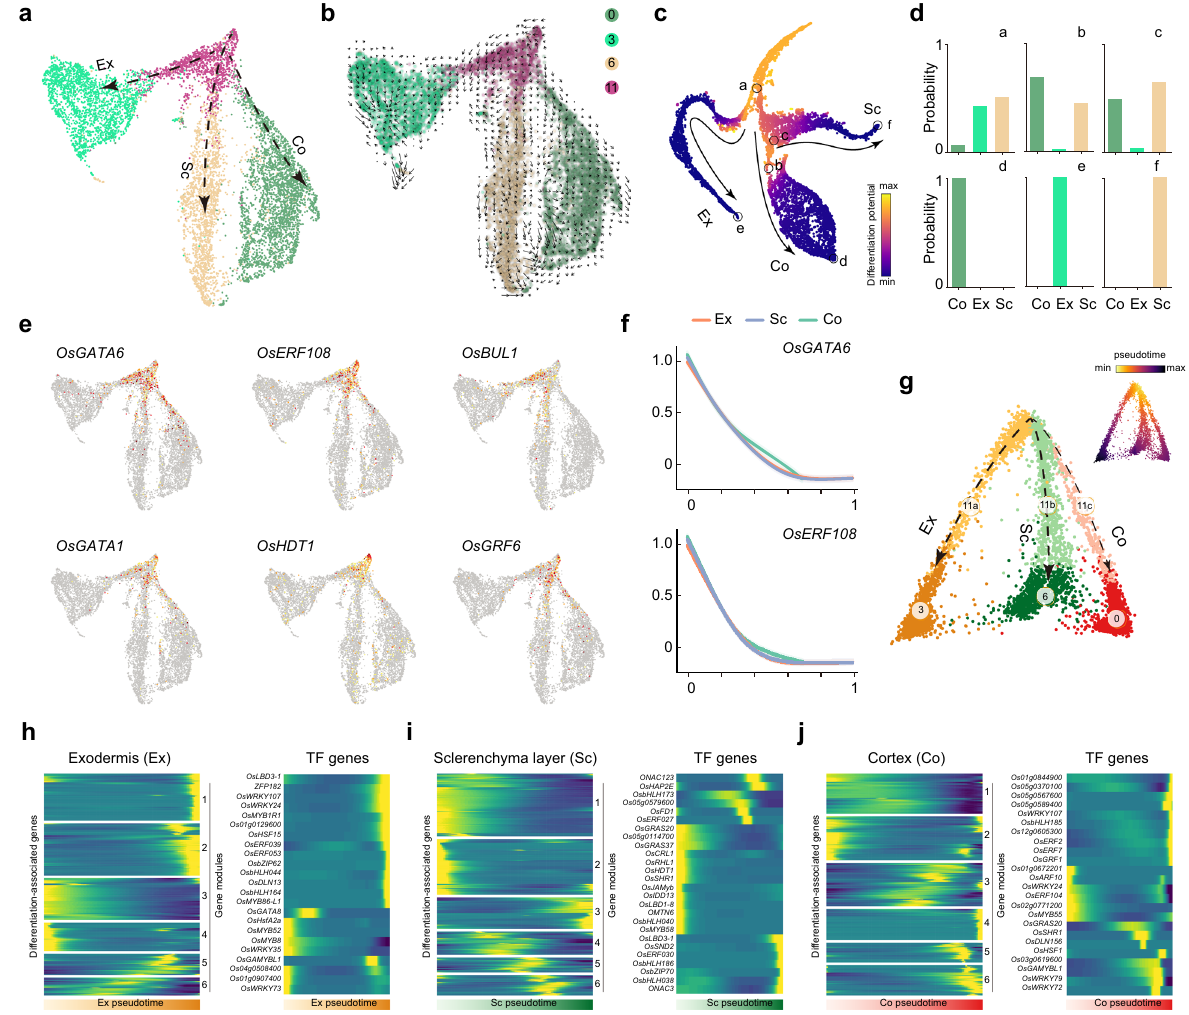
Fig. 3 Differentiation trajectories of ground tissue. a UMAP plot showing ground tissue cell populations. Ex, exodermis; Co, cortex; Sc, sclerenchyma layer. Cluster names (Clusters 0, 3, 6, and 11) and colors are the same as in Fig. 1a. b RNA velocity fi eld projected onto the UMAP. Arrows represent average velocity and direction. Cluster names and colors are the same as in a . c , d t -SNE map of ground tissue cell populations. Cell colored by differentiation potential ( c ). Black lines mark three major differentiation trajectories toward Ex, Co, and Sc, respectively. a to f (black circles), six nodes used for quanti fi cation of branch probabilities ( d ). e , f Expression patterns of selected transcription factor genes on UMAP map ( e ) or along pseudotime ( f ). Expression of OsGATA6 and OsERF108 was greatly decreased along pseudotime during cell differentiation toward Ex, Co and Sc. g Pseudotime analysis of ground tissue differentiation trajectories by DPT. The cells in clusters 0, 3, 6 and 11 were grouped and re-clustered. Three differentiation trajectories are shown in different colors. Inset, pseudotime estimation. h – j Heatmap showing gene expression pattern during differentiation of Ex ( h ), Sc ( i ), and Co ( j ) along pseudotime (left column). Expression pattern of selected transcription factor (TF) along each differentiation trajectory is given (right